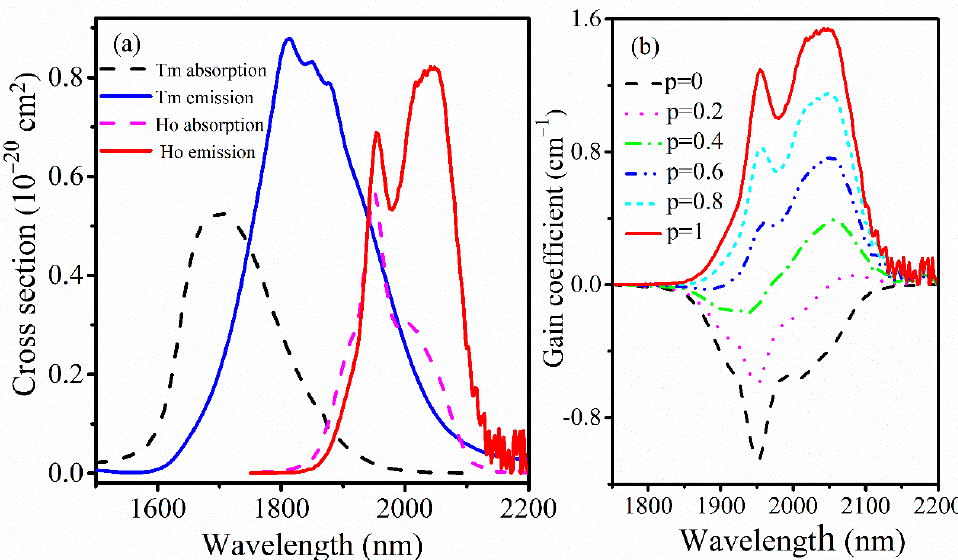
Figure 7. ( a ) Absorption and emission cross sections of Tm 3+ and Ho 3+ ions, corresponding to Tm 3+ : 3 H 6 ↔ 3 F 4 and Ho 3+ : 5 I 8 ↔ 5 I 7 transitions; ( b ) the effect of 5 I 7 → 5 I 8 transition wavelength on the gain coefficient in gallium tellurite glasses. Table 1. Energy transfer parameters between Tm 3+ and Ho 3+ in TGBTH-y sample. Energy